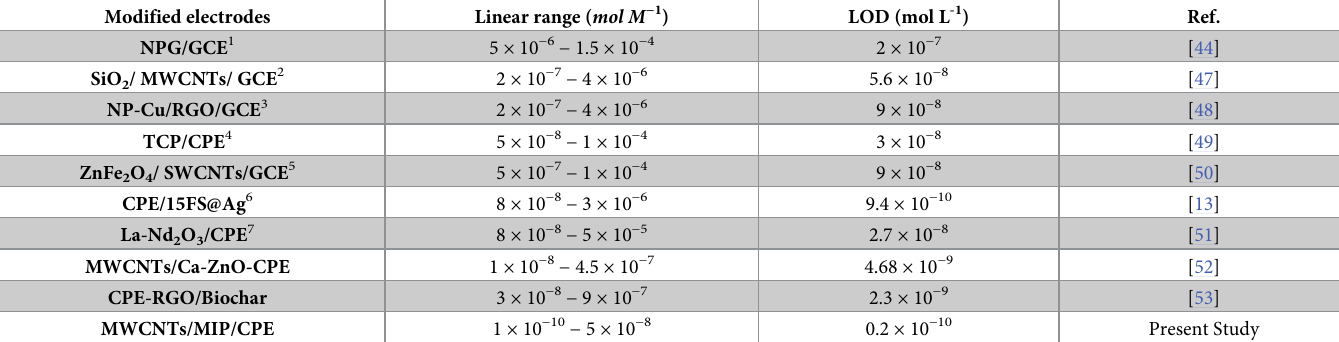
Table 2. Limit of detection of the present and some of the previously published studies. Modified